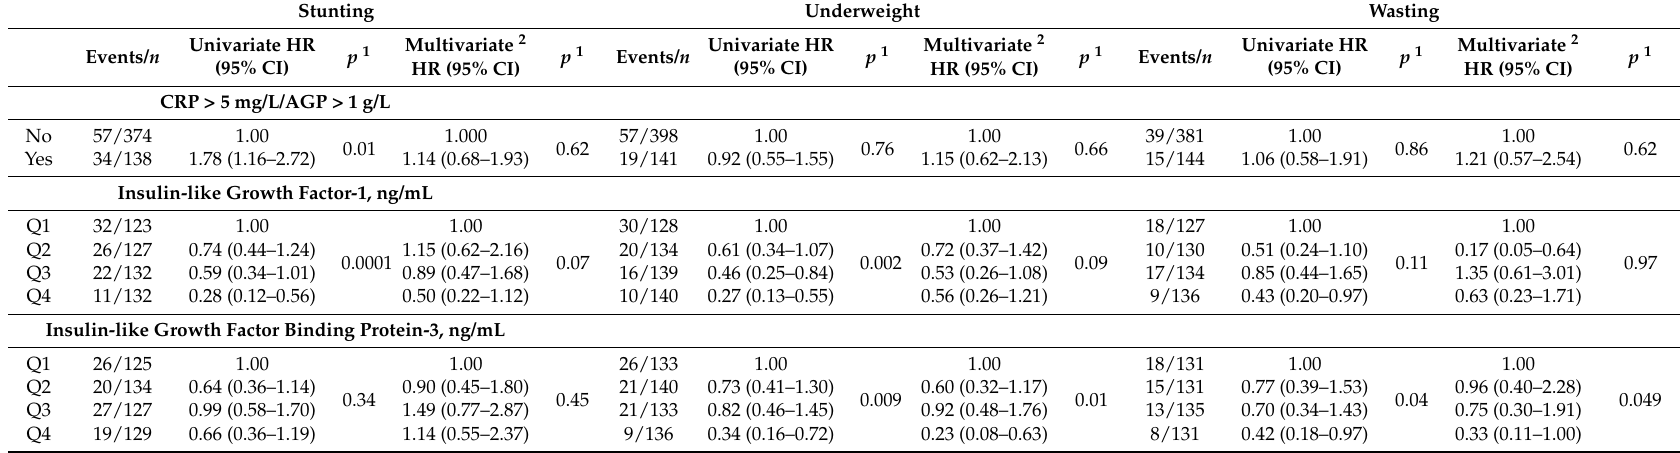
Table 4. Association of inflammatory (CRP, AGP) and growth (IGF-1, IGFBP-3) biomarkers at 6 months with subsequent stunting, wasting, and underweight. Stunting Underweight